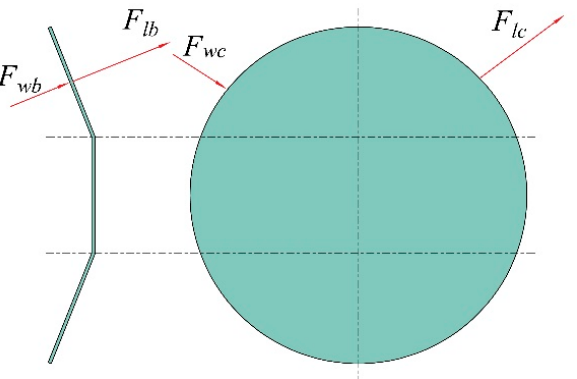
Figure 10. Schematic force analysis on the corresponding section of the bent plate and typical bluff body.